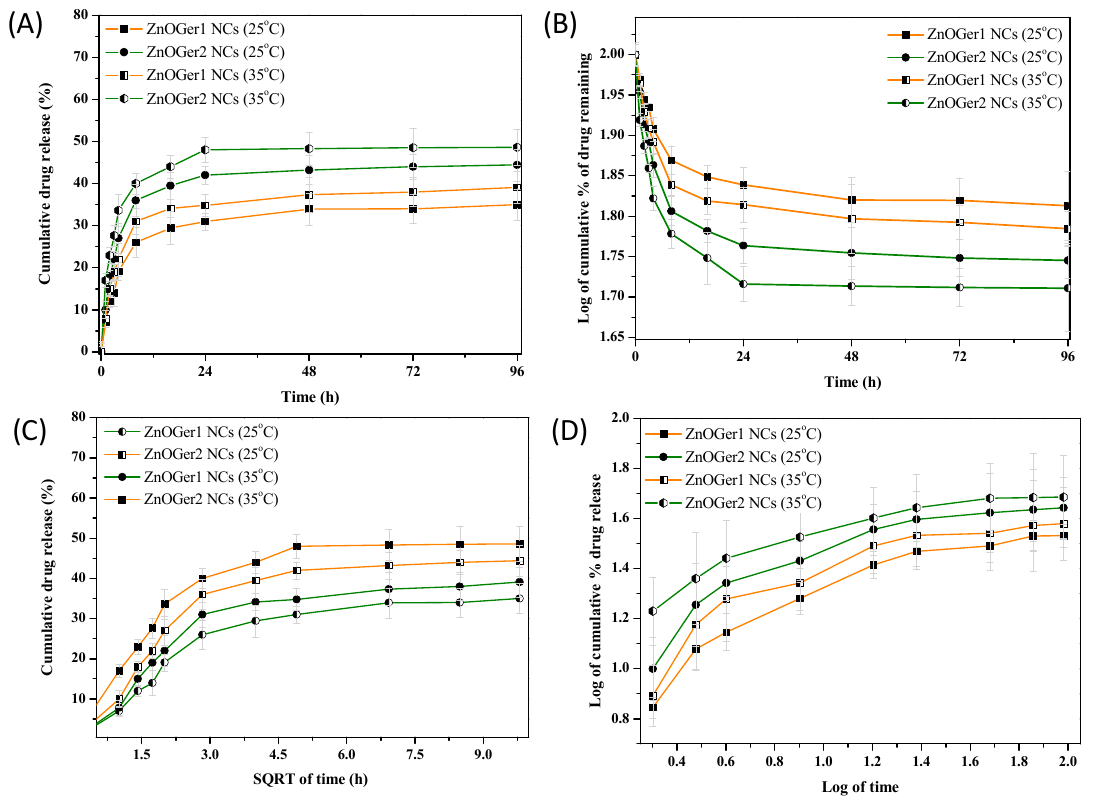
Figure 4. Effects of temperature (25 ± 0.5 °C and 35 ± 0.5 °C) on the stability of ZnOGer1 NCs and ZnOGer2 NCs released geraniol in a 96 h period. Pharmacokinetics for analyzing the release mechanism via zero-order ( A ), first-order ( B ), Higuchi ( C ), and Korsmeyer–Peppas models ( D ).